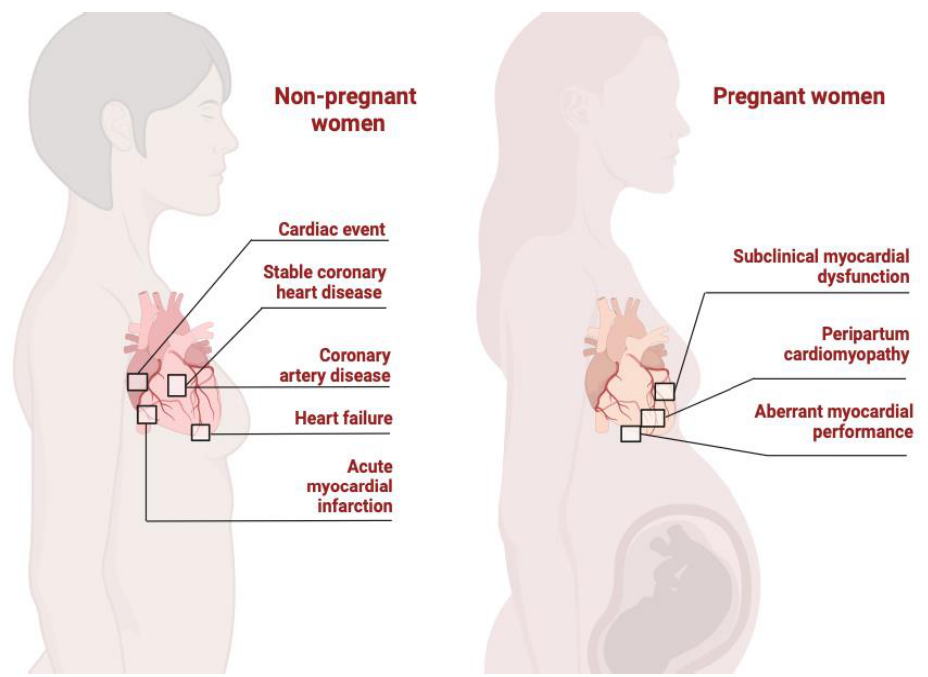
Figure 3. Illustrates interaction between sFlt1/PlGF ratio and cardiovascular disease in unpregnant and pregnant